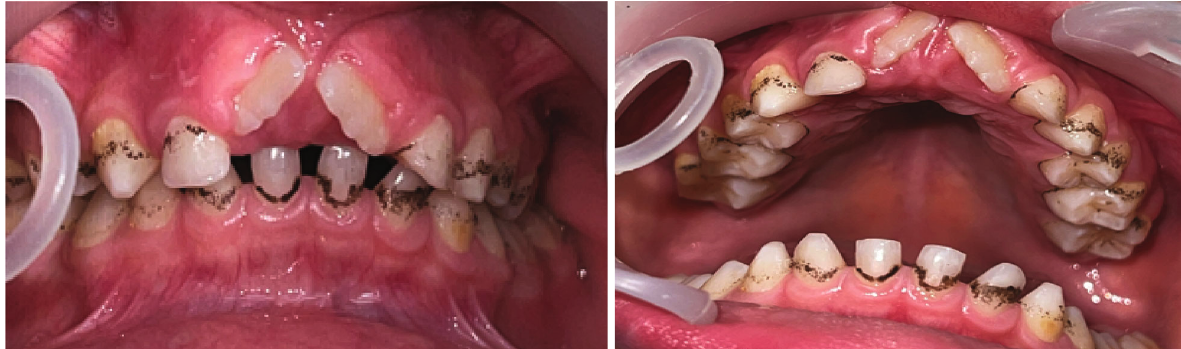
Figure 1: Chromogenic bacteria, rotation of the lower incisors, and a high narrow palate.